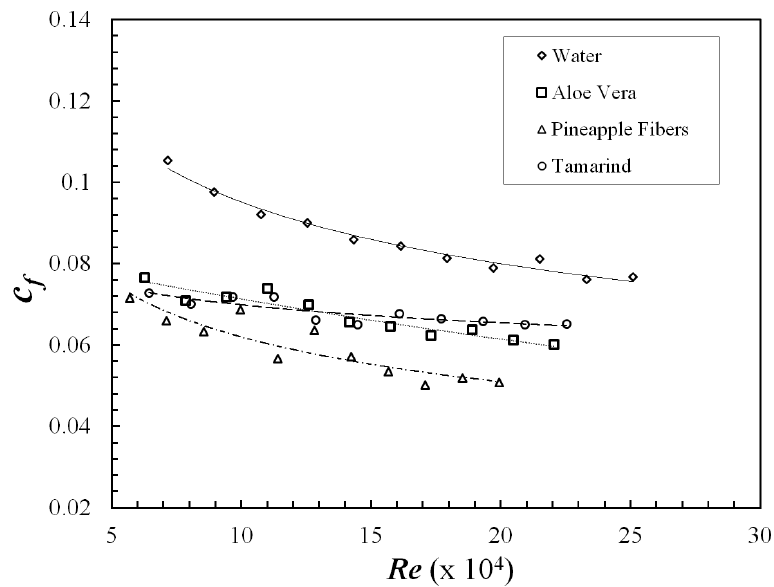
Figure 6. Skin friction coefficient vs. Reynolds number for polysaccharides.